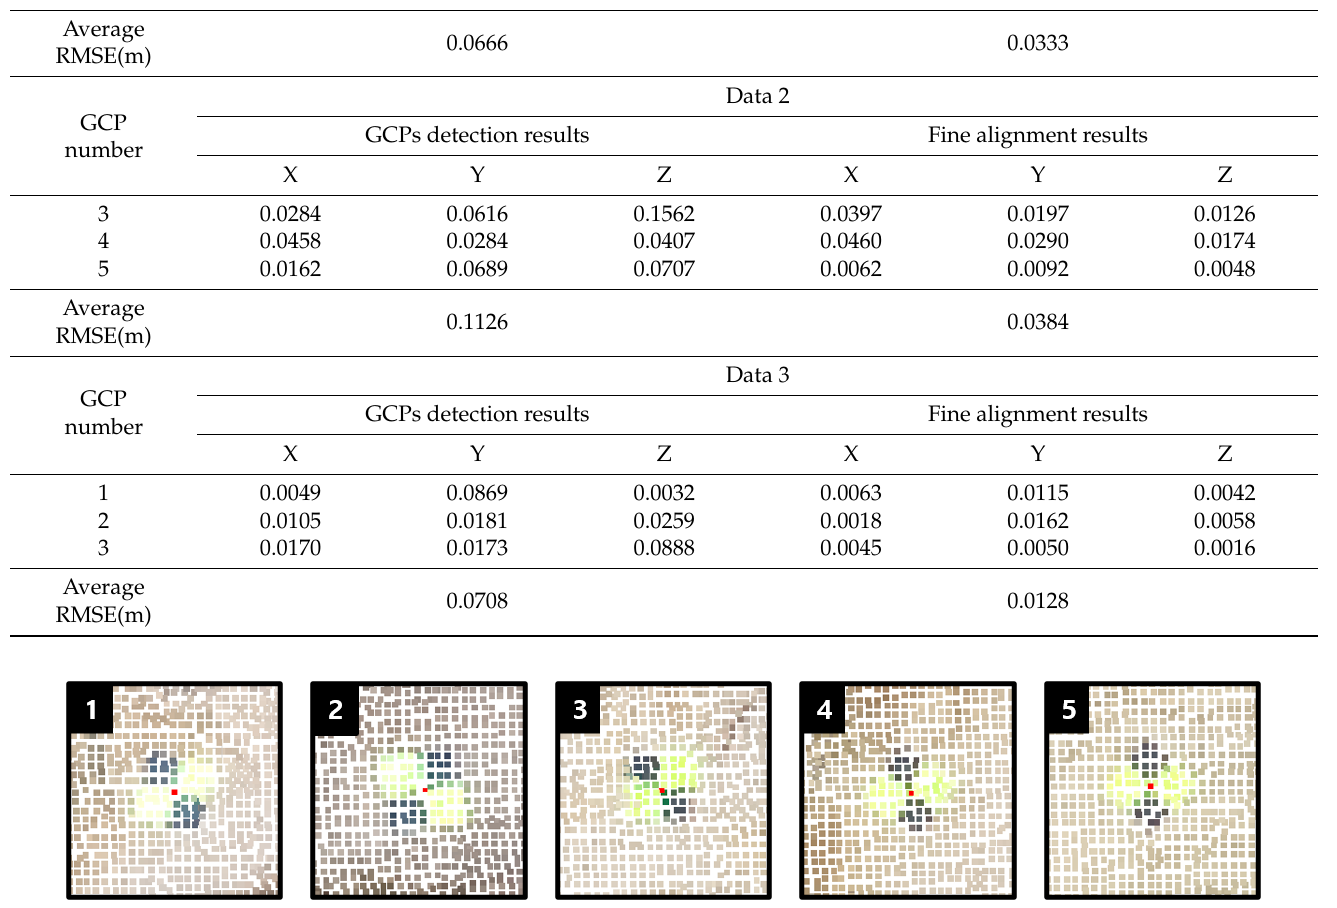
Figure 11. Visualization of the fine alignment results of Data 1. Red points represent GNSS coordi- nates.